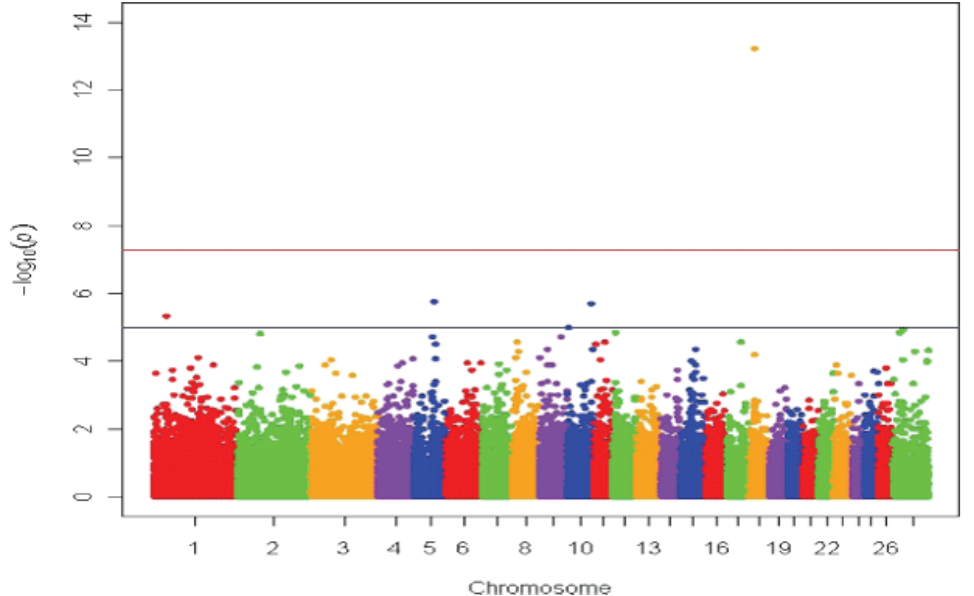
Figure 2. Manhattan plot for Mean Corpuscular Hemoglobin Concentration (MCHC) GWAS. The Manhattan plot shows nominal P -values from association with mean corpuscular hemoglobin concentration (MCHC) of erythrocytes by chromosomal position. Representative data from the all-breeds, genotypic mode of inheritance analysis is shown. The top red line shows a genome-wide significance threshold defined by nominal P - values of 1 6 10 2 6 , which is P =0.05/50,000. The lower blue line shows a genome-wide suggestive significance threshold defined by 1 6 10 2 5 .